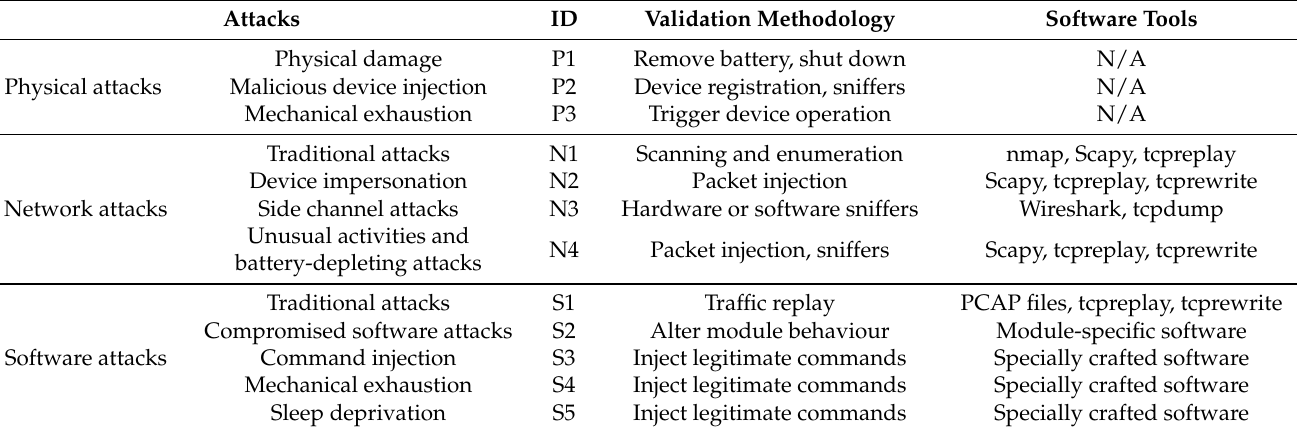
Table 1. Summary of attacks.